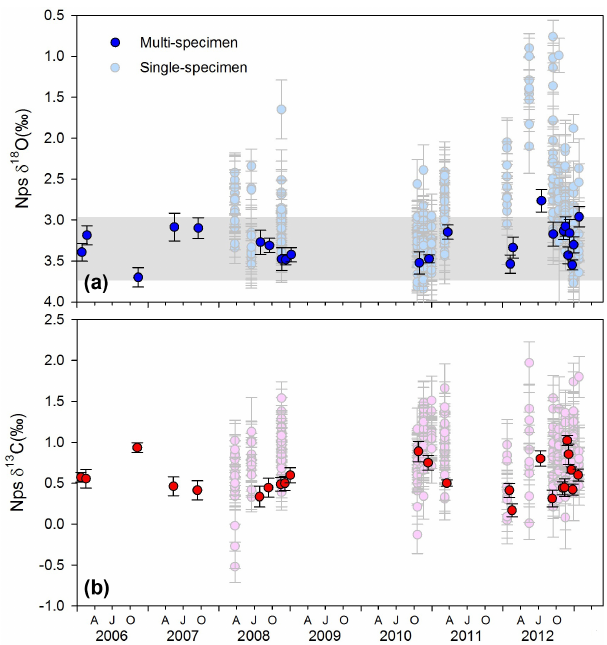
Figure 6. Multi-specimen and single-specimen adult Neoglobo- quadrina pachyderma (Nps) stable isotope dataset (VPDB) show- ing (a) δ 18 O np (blue) and (b) δ 13 C np (red). Grey horizonal bar shows the range of calculated δ 18 Oeq . values for the depth range 50–100m, using seawater temperature and salinity profiles in the World Ocean Atlas 13 dataset (see Fig. S13 for comparison of calcu- lations to measured δ 18 O sw profiles). Error bars show ± 1SD. AJO: April (autumn), July (winter), October